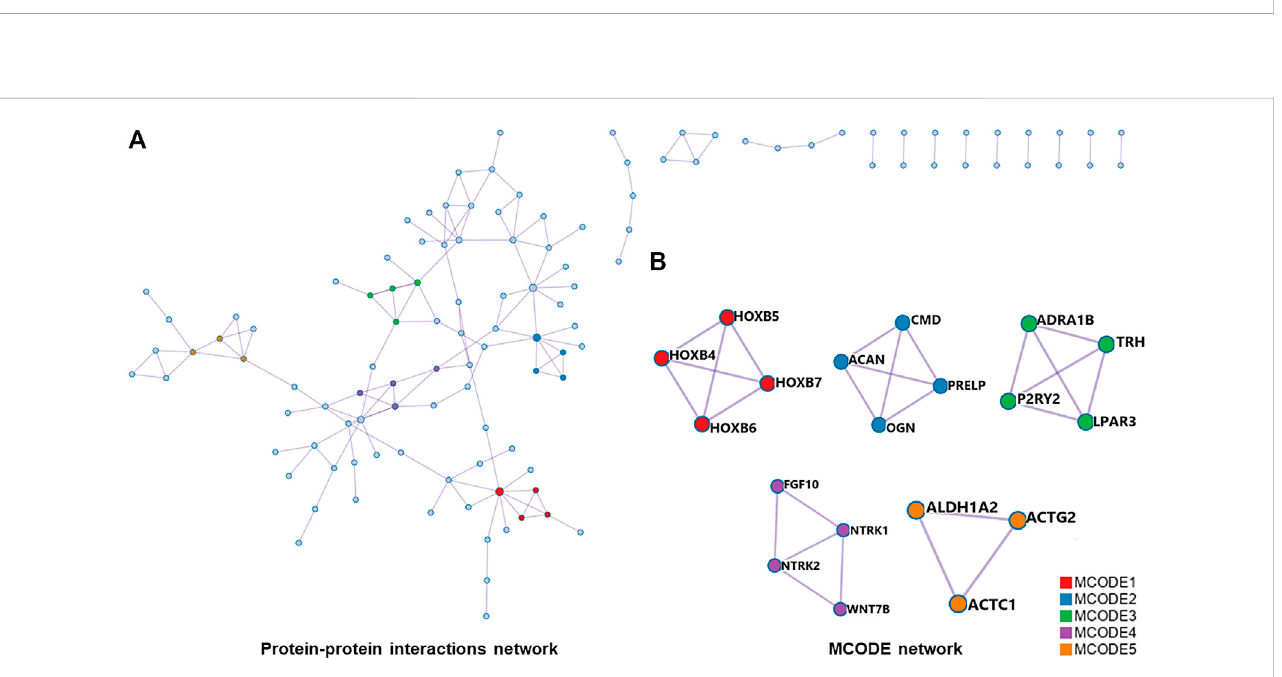
FIGURE 6 (A) , all protein-protein interactions among differentially expressed mRNAs were extracted from PPI data source and formed a PPI network. (B) , MCODE algorithm was applied to identify neighborhoods where proteins were densely connected. Five MCODE modules were enriched. PPI, protein-protein interaction; MCODE, Molecular Complex